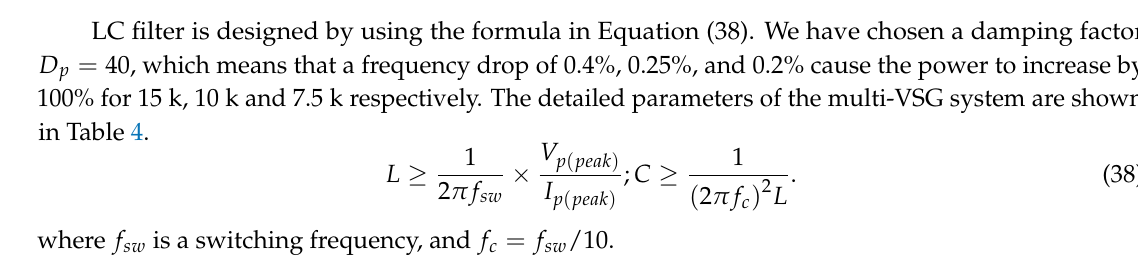
Figure 10. Island microgrid of a multiple-VSG system.